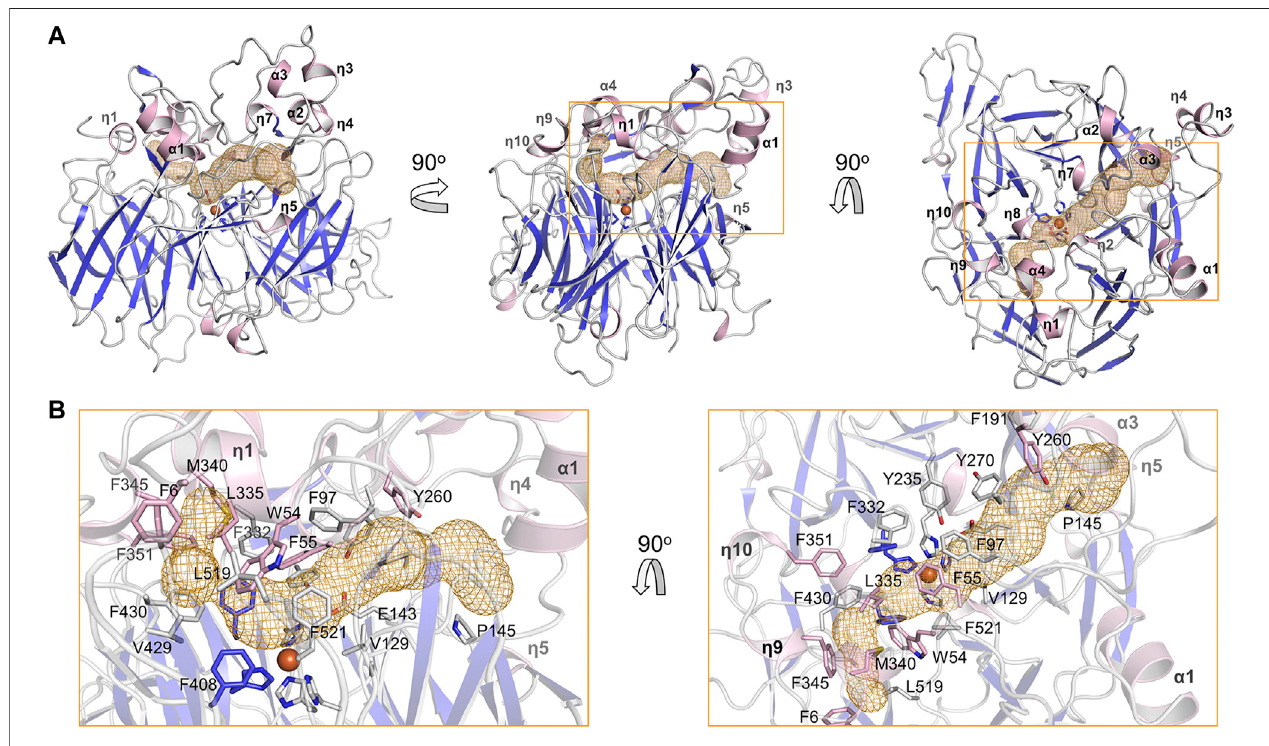
FIGURE 3 | Substrate tunnel of BCMO-1. (A) Ribbon representation of BCMO-1 and mesh representation of the substrate tunnel. The color scheme is as in Figure 1C ; the tunnel is in orange; boxes denote zoomed regions shown in B. The orientation in the left panel is same to that in Figure 1B (right panel). (B) Zoomed-in view of the tunnel. Ribbons are in transparence; side chains of Phe6, Trp54, Phe55, Phe97, Val129, Glu143, Pro145, Phe191, Tyr235, Tyr260, Tyr270, Phe307, Phe332, Leu335, Met340, Phe345, Phe351, Phe408, Val429, Phe430, Leu519, Phe521, and the iron-coordinating His are shown as